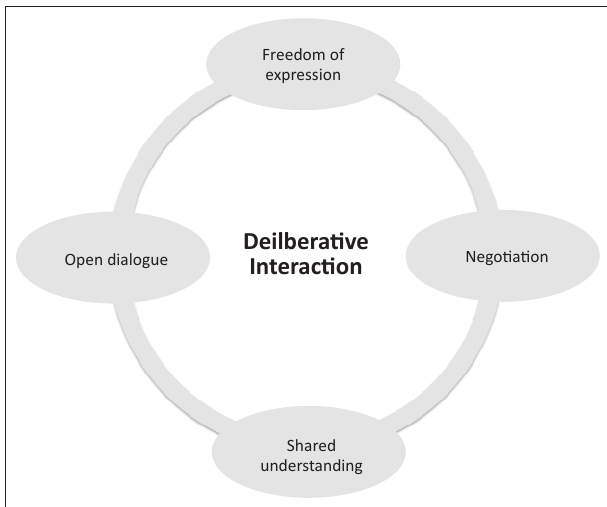
FIGURE 1: Components of deilberative